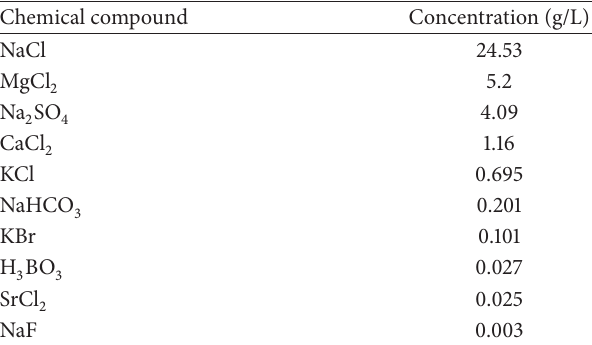
Table 2: Chemical compounds in sea